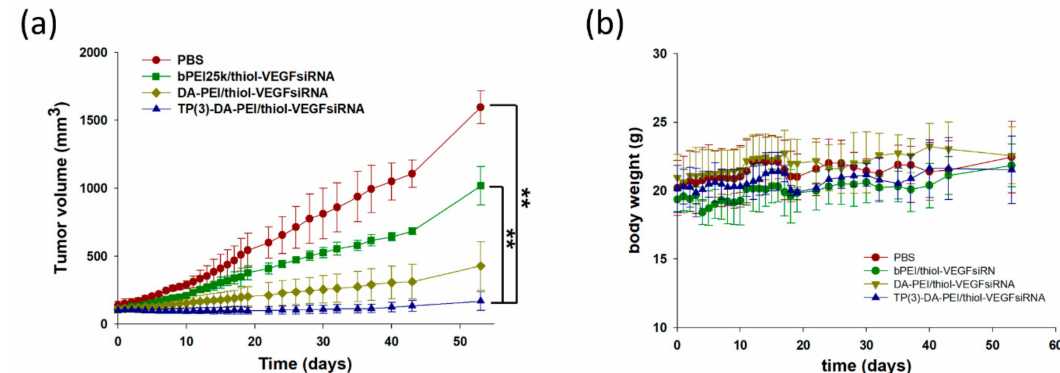
Figure 8. ( a ) Effect of tumor growth inhibition and ( b ) body weights of PBS, bPEI25k/thiol-VEGF siRNA, DA-PEI/thiol-VEGF siRNA, and TP(3)-DA-PEI/thiol-VEGF siRNA groups in A549 tumor-bearing mice via intravenous injection. The results are presented as means ± SD and analyzed using Student’s t -test ( n = 5, ** p < 0.01).